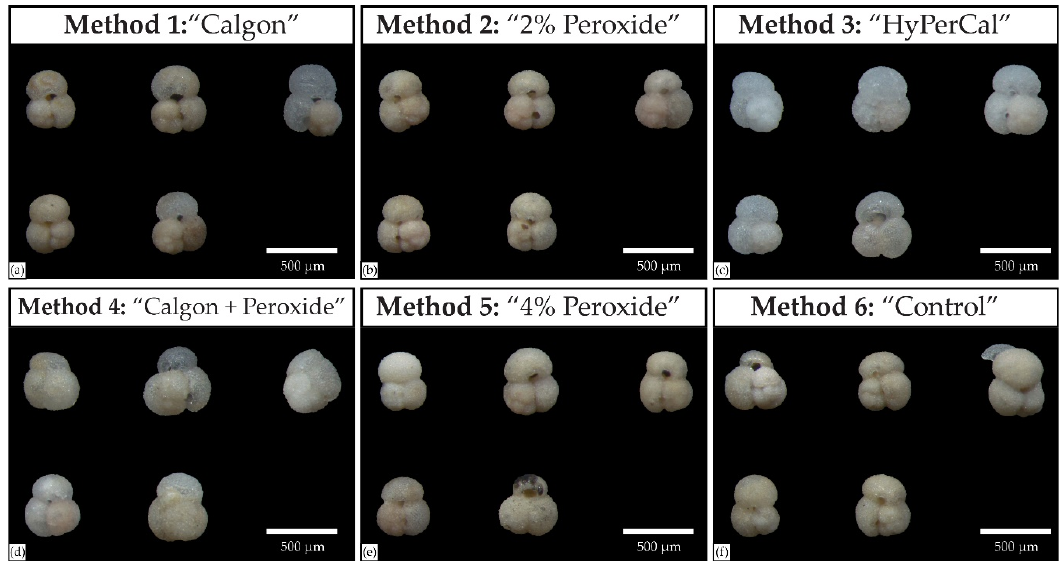
Figure 1. Images of the analyzed specimens after their treatment with the different cleaning protocols.